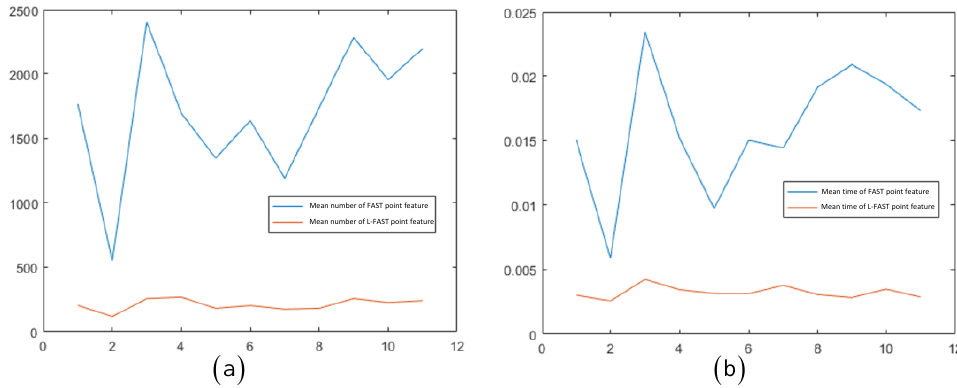
Figure 10. The average time ( a ) and number ( b ) results of each sequence.